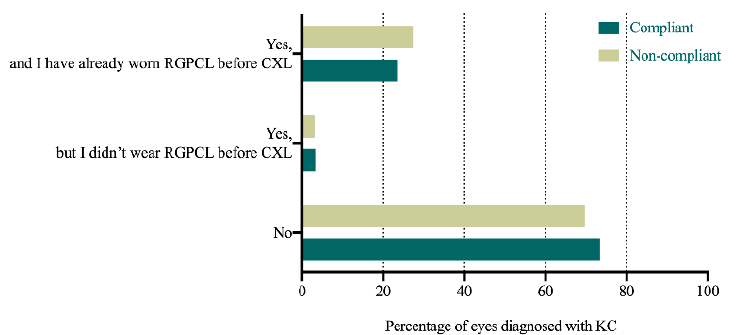
Figure 2. Comparison of the answers to the question “In which treatment do you have better visual acuity?” between the compliant and non-compliant groups (RGPCL, rigid gas-permeable contact lens; KC, keratoconus).